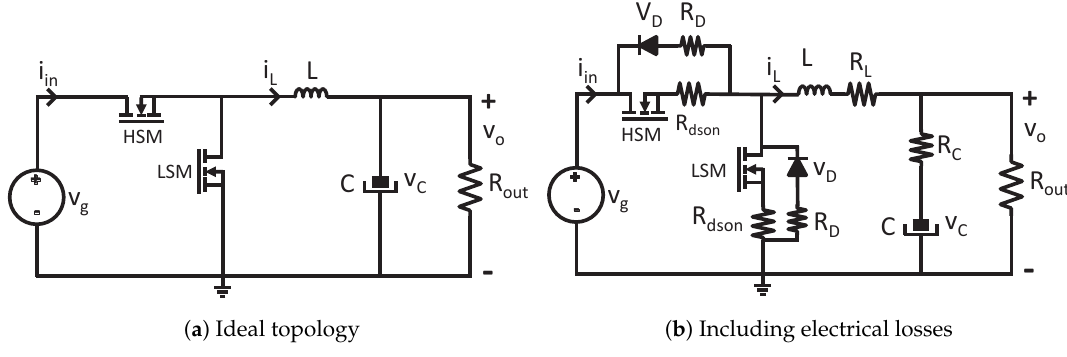
Figure 1. Topology of a synchronous Buck